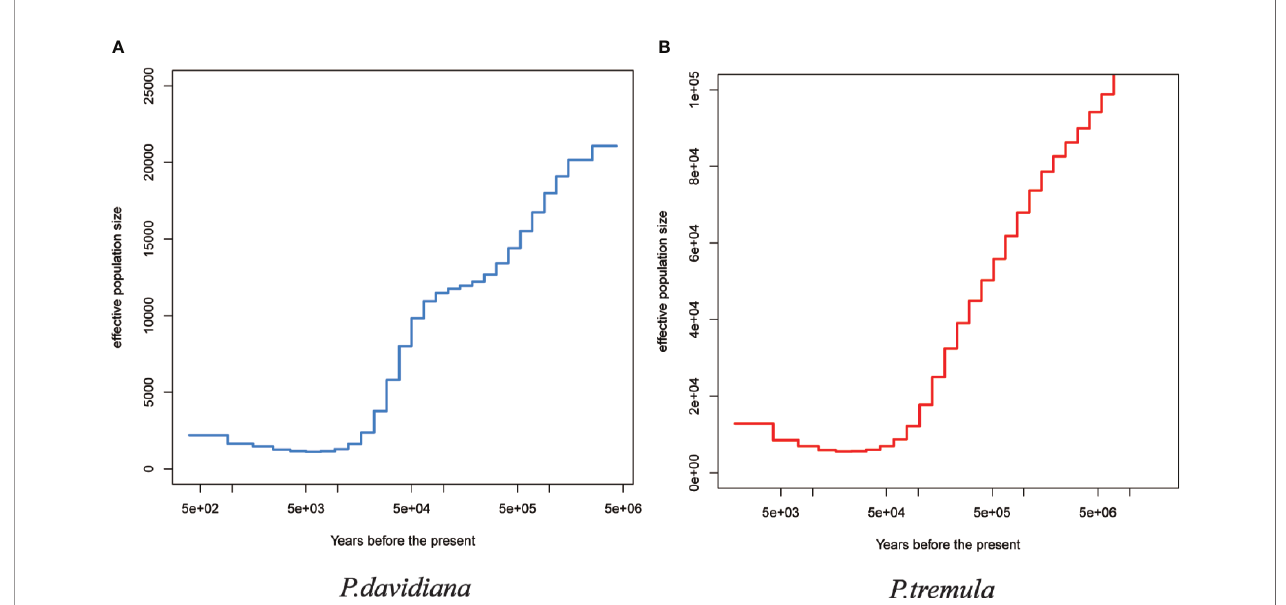
FIGURE 5 | The effective population size of (A) P. davidiana and (B) P. tremula (Ne) over historical time implementing by